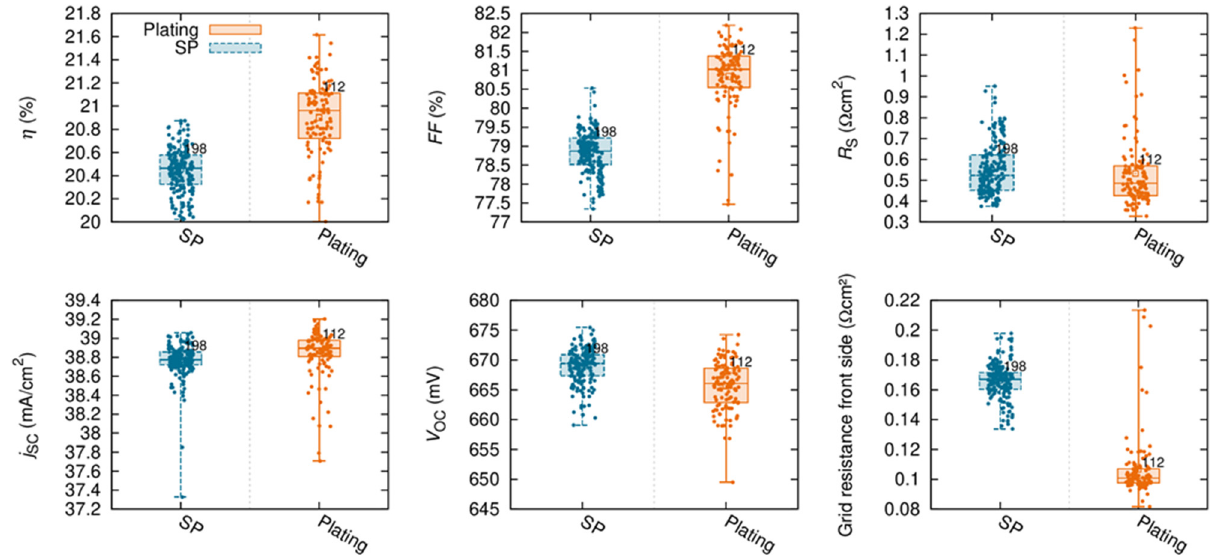
Fig. 3. IV results for plated and screen-printed (SP) bifacial TOPCon solar cells.